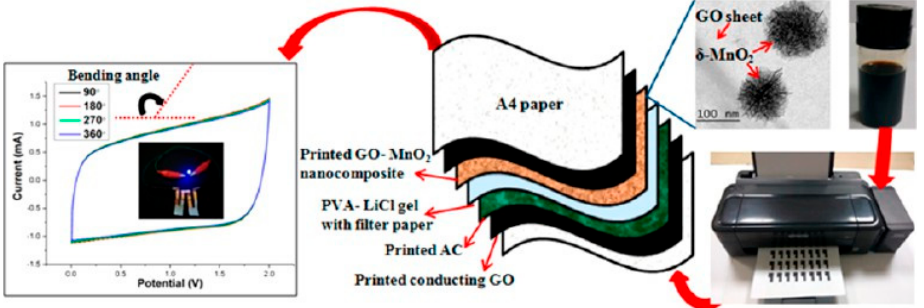
Figure 18. Preparation of supercapacitors by inkjet printing MnO 2 ink, and characterization of its structure and properties. Reproduced from [99], with permission from American Chemical Society, 2017.